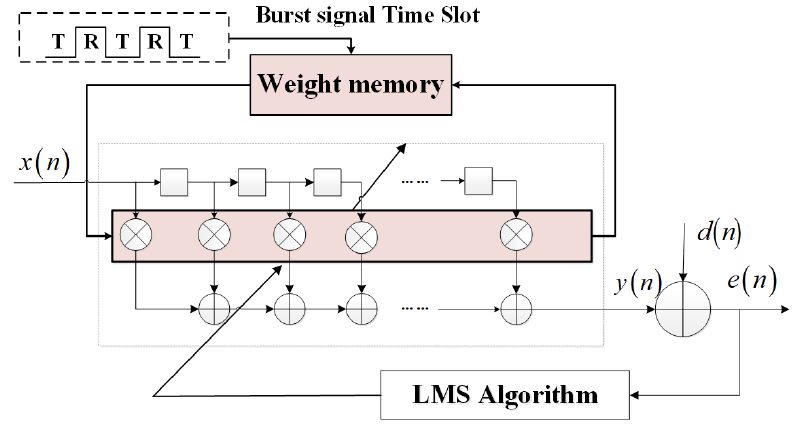
Figure 8. The flow chart of the robust anti-jamming algorithm.